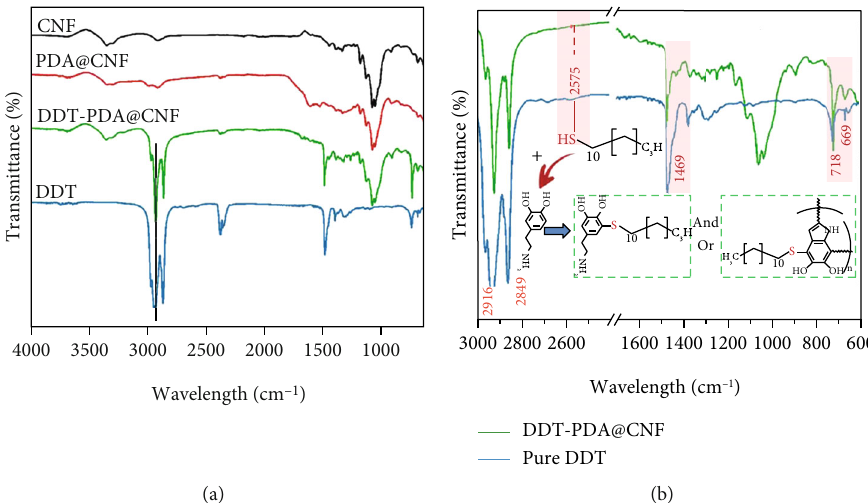
Figure 5: (a) FTIR spectrum of CNF, 0.5PDA@CNF, and DDT-0.5PDA@CNF and (b) zoom-in FTIR spectrum of DDT-0.5PDA@CNF and pure DDT in range of 3000 to 600 cm -1 .